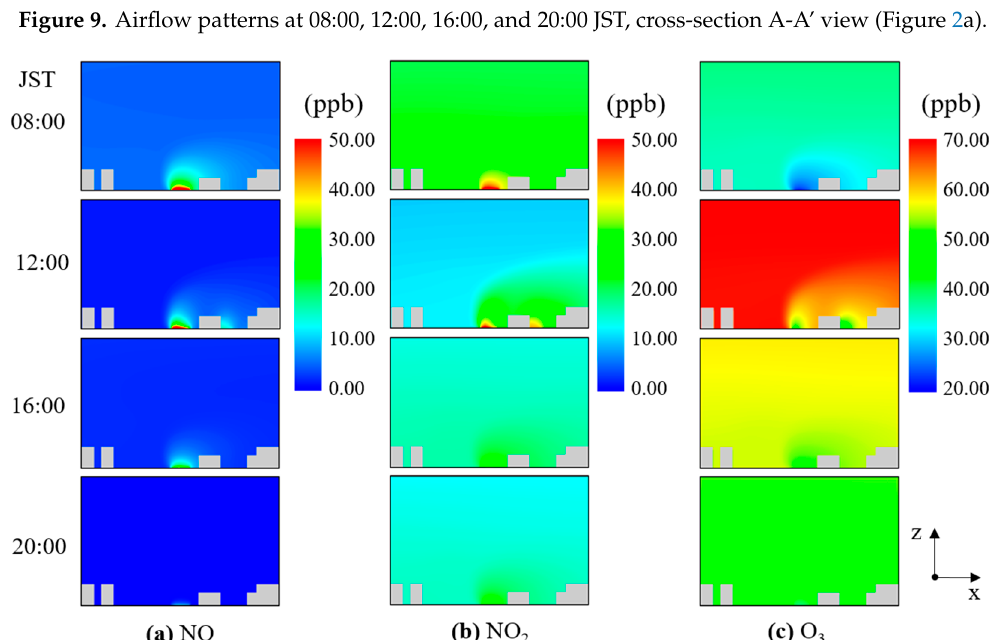
Figure 9. Airflow patterns at 08:00, 12:00, 16:00, and 20:00 JST, cross-section A-A’ view (Figure 2a).